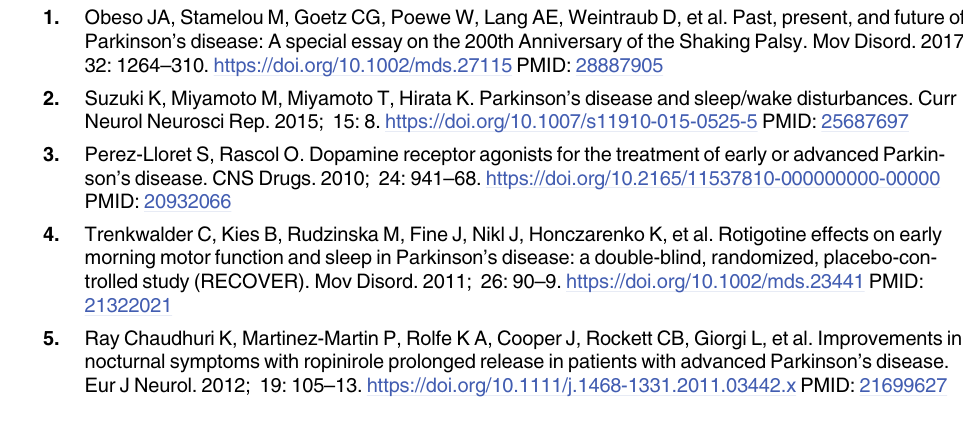
S1 Fig. Scatter plots showing the nocturnal motor symptoms, nocturnal symptoms domain scores, and drug dosage. S2 Fig. Plots showing the scores for items 2, 3, and 14 of PDSS-2 against drug dosage. (TIF) S3 Fig. Plots showing the scores for items 1 and 8 of PDSS-2 against dosage of DA. S4 Fig. Plots showing the scores for item 8 of PDSS-2 against the LED ratio of